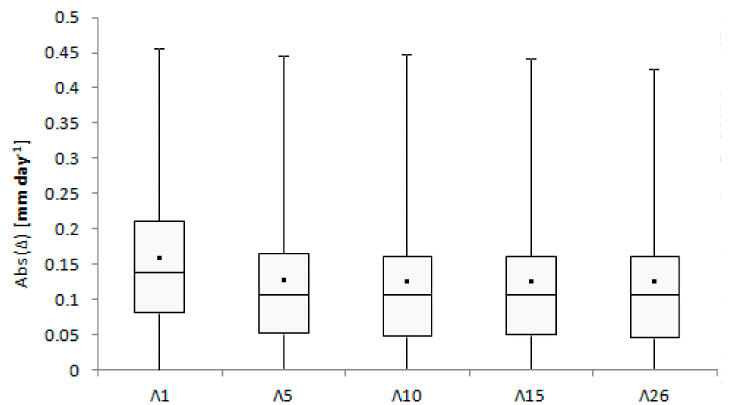
Figure 4. Box plot of the absolute ∆ depending on the number of Λ used for